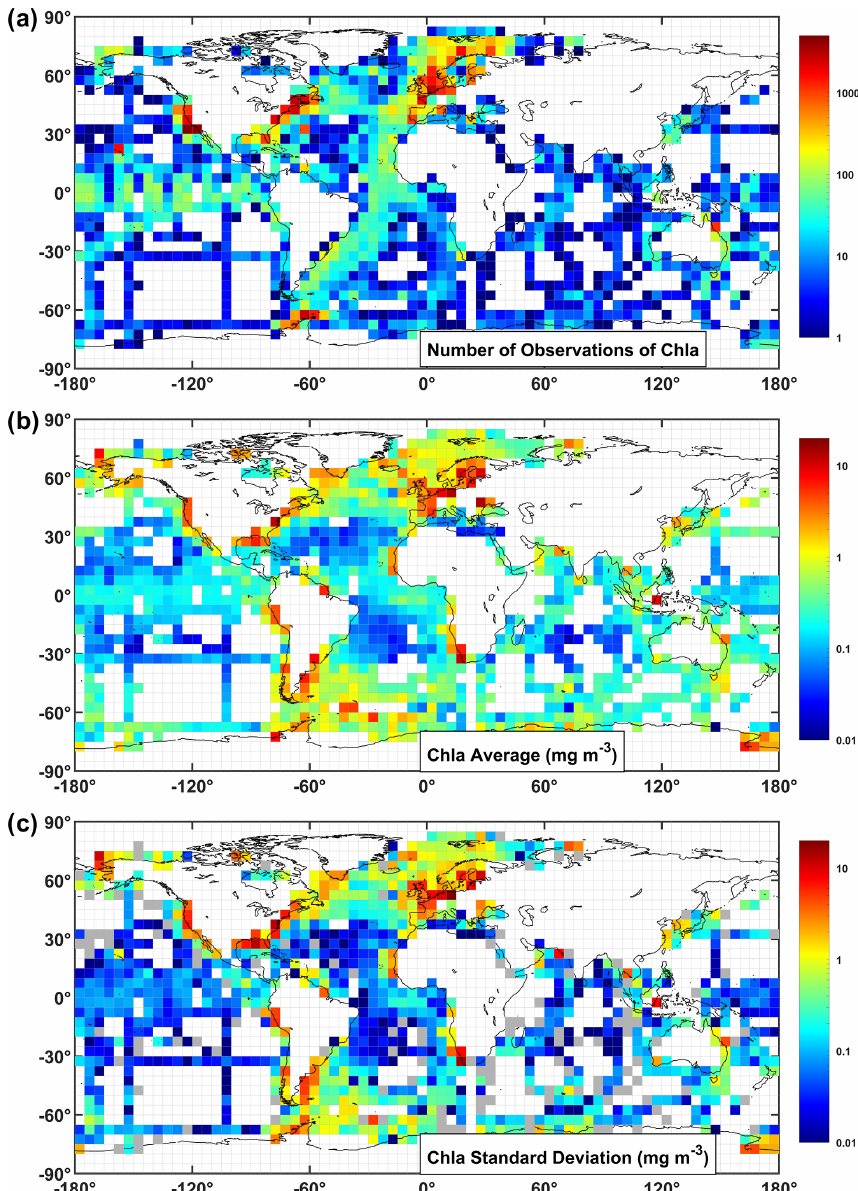
Figure 10. The chlorophyll- a (mgm − 3 ) data partitioned into 5 ◦ × 5 ◦ boxes showing (a) number of observations, (b) average value, and (c) standard deviation in each box. All chlorophyll data were considered, but for a given station, HPLC data were selected if available. In the standard deviation plot, grey colour boxes represent zero standard deviation (i.e. one